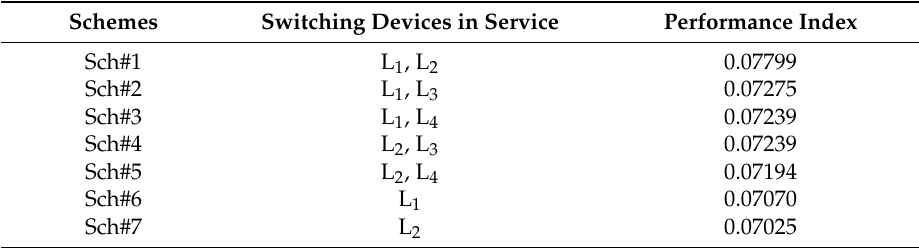
Table 8. The feasible set in Case